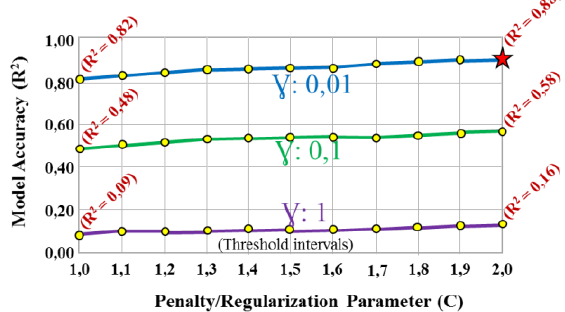
Figure 3 . Model accuracies for different ( C , Ɣ ) pairwise